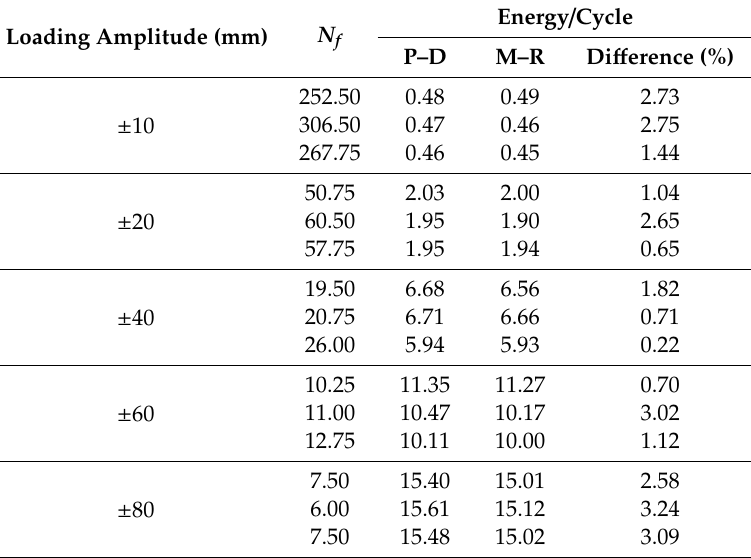
Table 1. Number of cycles to failure and energy for each